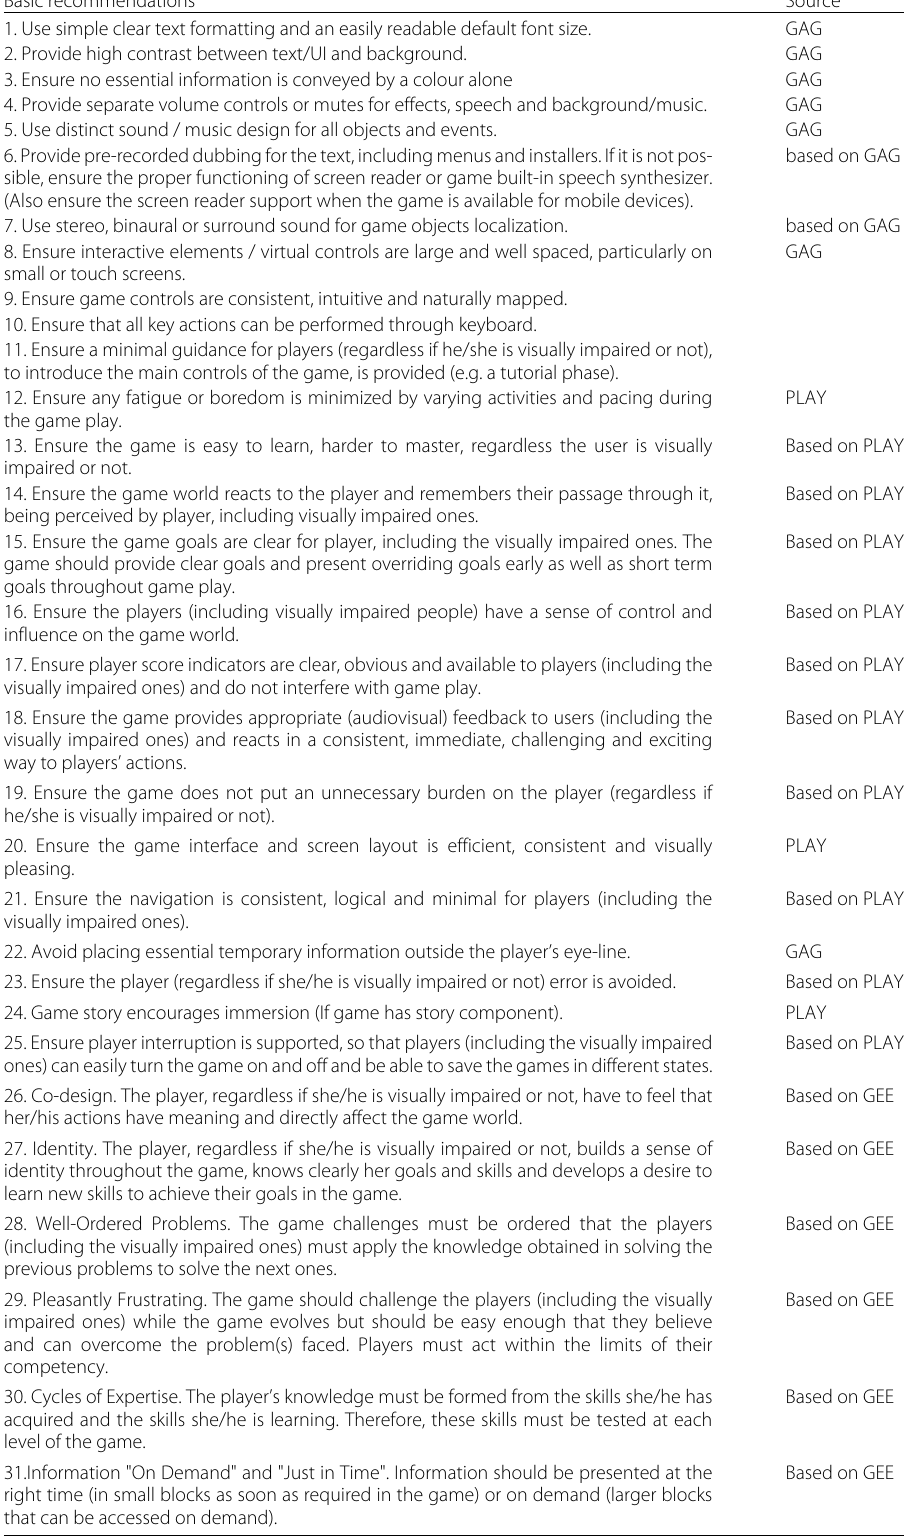
Table 1 EdugameAccess’ basic recommendation set Basic